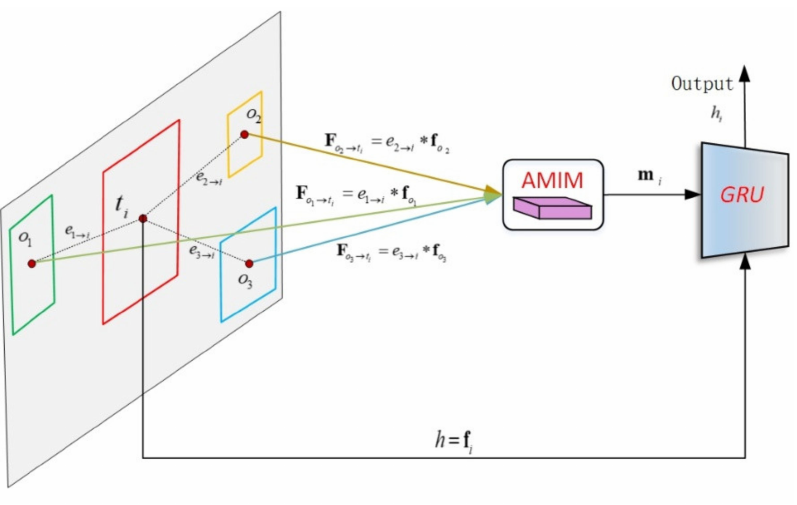
Figure 7. Object relational structured graph